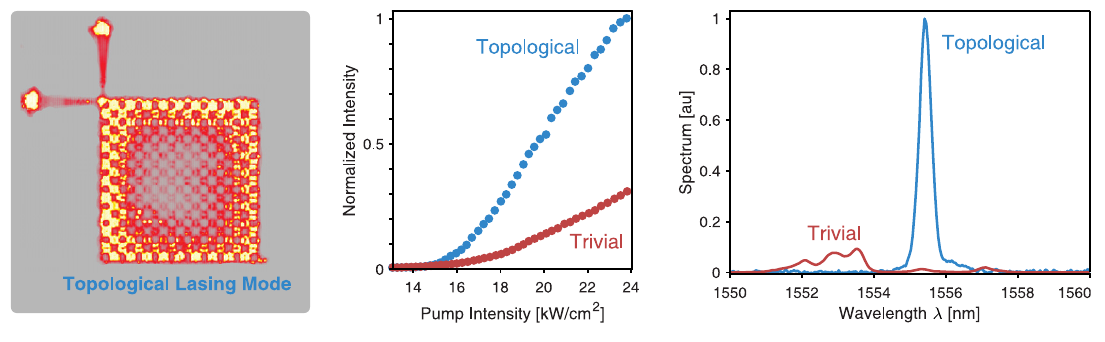
Figure 5: Topological insulator laser [34, 35]. Left toright:Top viewphotographof the lasing pattern (topological edgemode)in a 10 × 10array of topologically connectedresonators, andthe outputports.Outputintensityversuspumpintensityforatopologicalinsulatorlaseranditscorrespondingtrivialcounterpart.Theenhancement of the slope ef fi ciency is approximately threefold. Emission spectra from a topological insulator laser and its topologically trivial